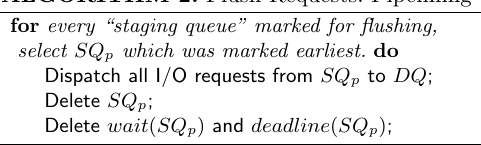
ALGORITHM 2: Flush Requests: